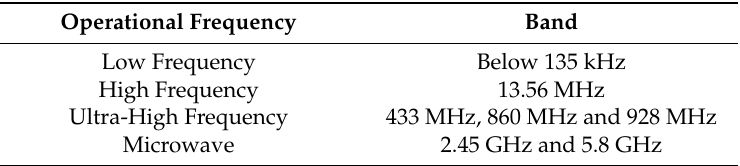
Table 3. Operational frequencies in RFID